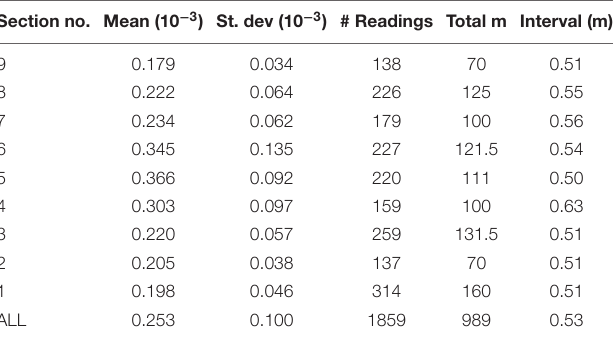
TABLE 2 | Basic statistics of MS measurements by KT-10 (field data) depicted in Figure 3A as curves constructed from individual MS values.